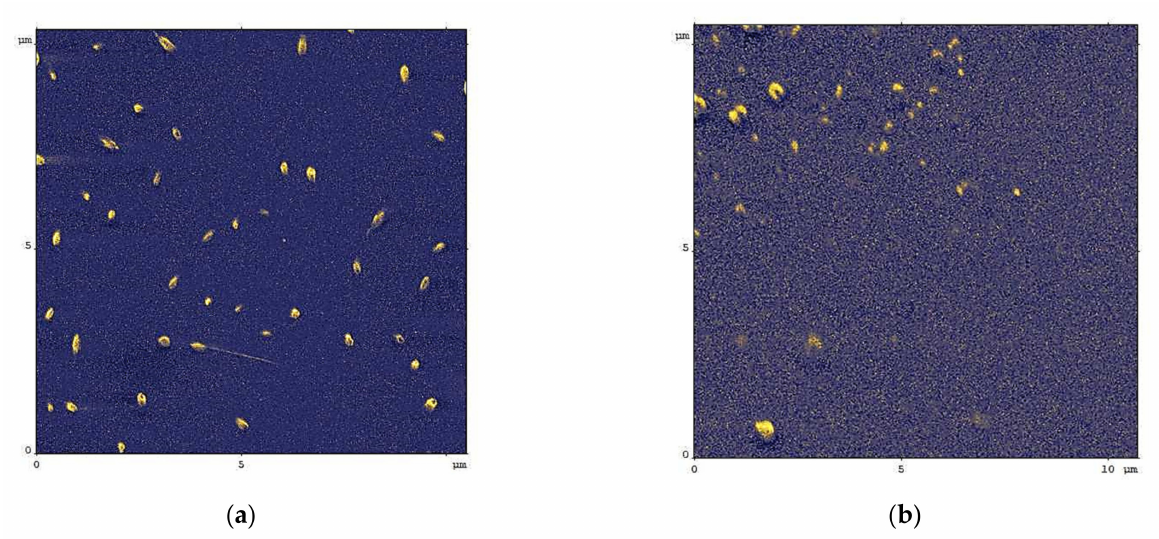
Figure 8. SEM images of coatings from IPEC with χ = 0.06 on the substrate: ( a ) glass; ( b ) PVC.